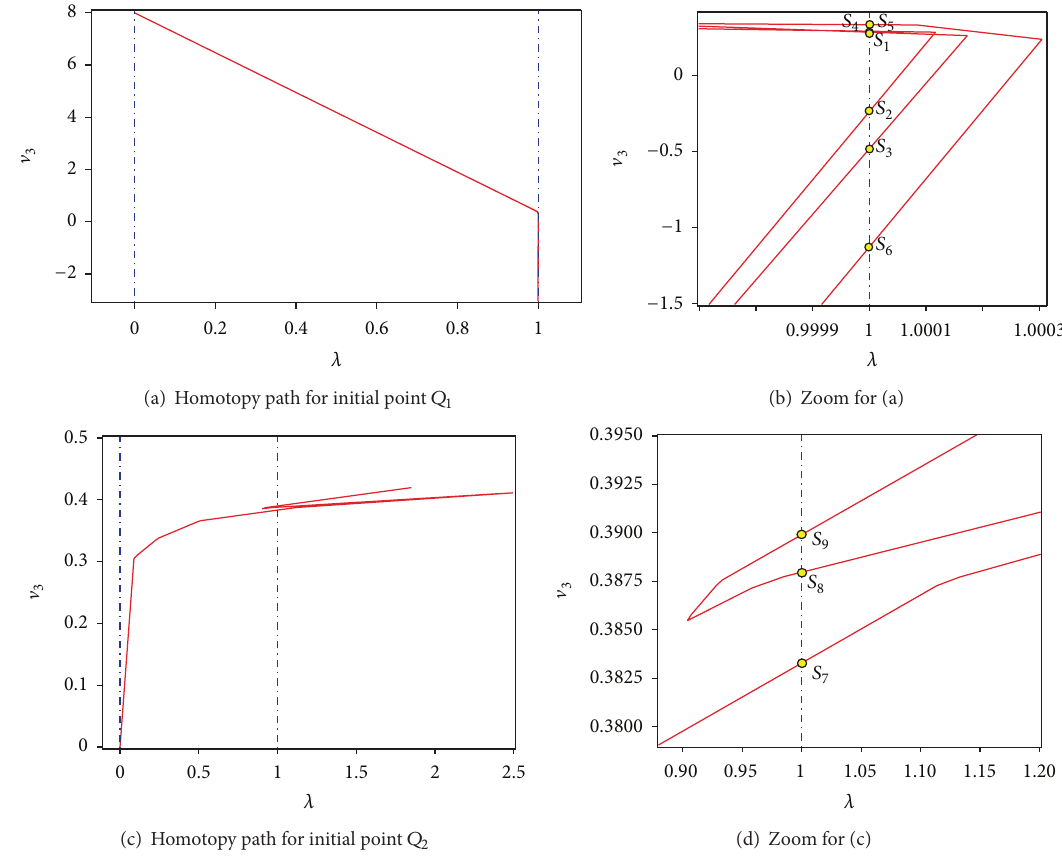
Figure 11: Homotopy paths for (18) projected over 𝜆 - V 3